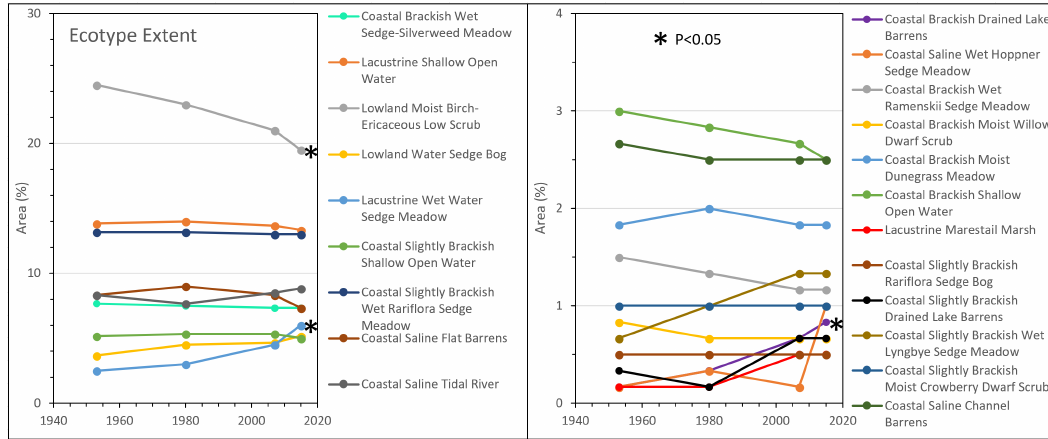
Figure 2. Changes in areal extent of ecotypes on the central coast of the Yukon-Kuskokwim Delta, evident in high-resolution imagery from ~1953, 1980, ~2007 and ~2015. Note difference in scales between left and right charts. Significant ( p < 0.05) changes noted with